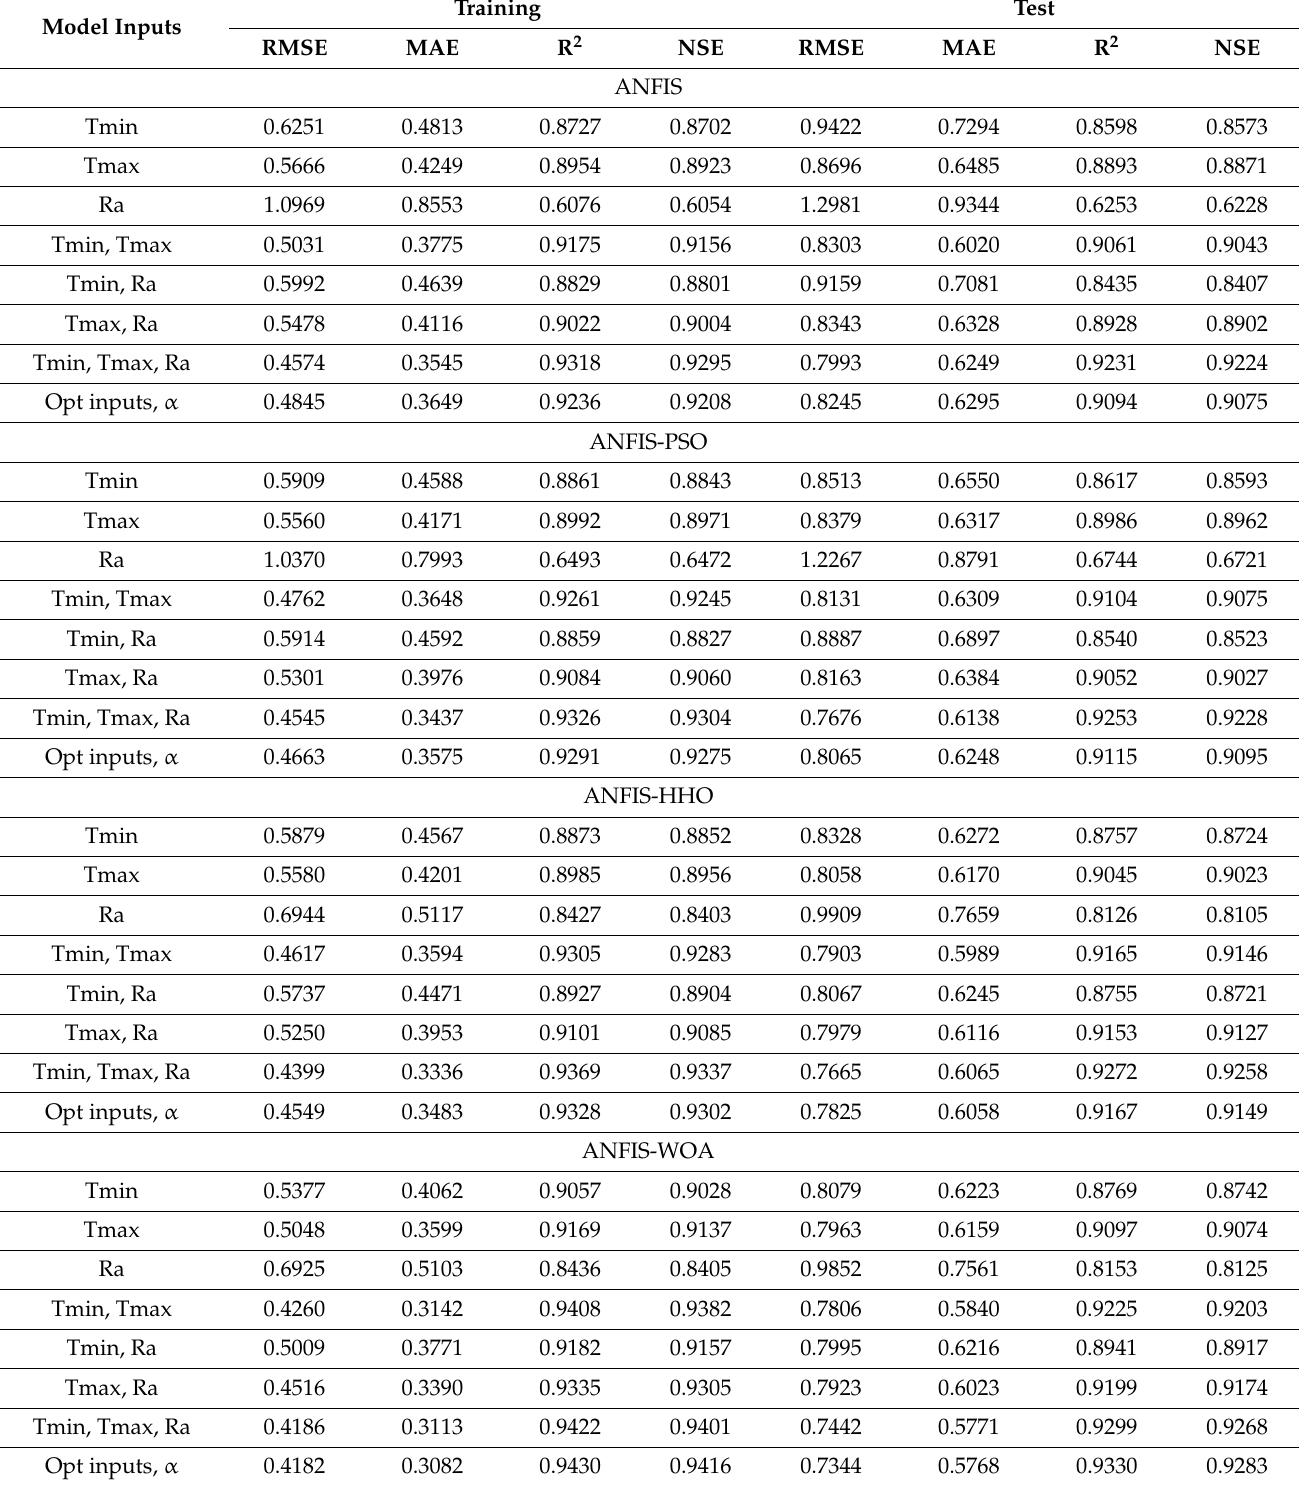
Table 8. Training and testing performances of the models for monthly Epan prediction—Nanxian Station using data from Yueyang